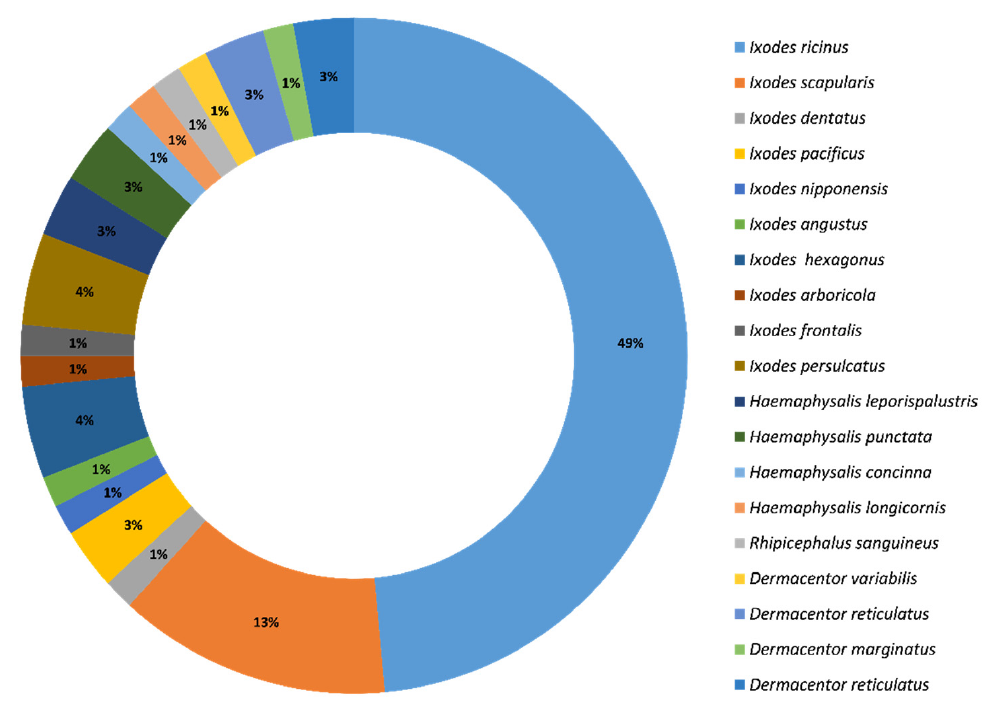
Figure 2. Reported proportions of tick species positive for Borrelia burgdorferi during the last two decades globally.